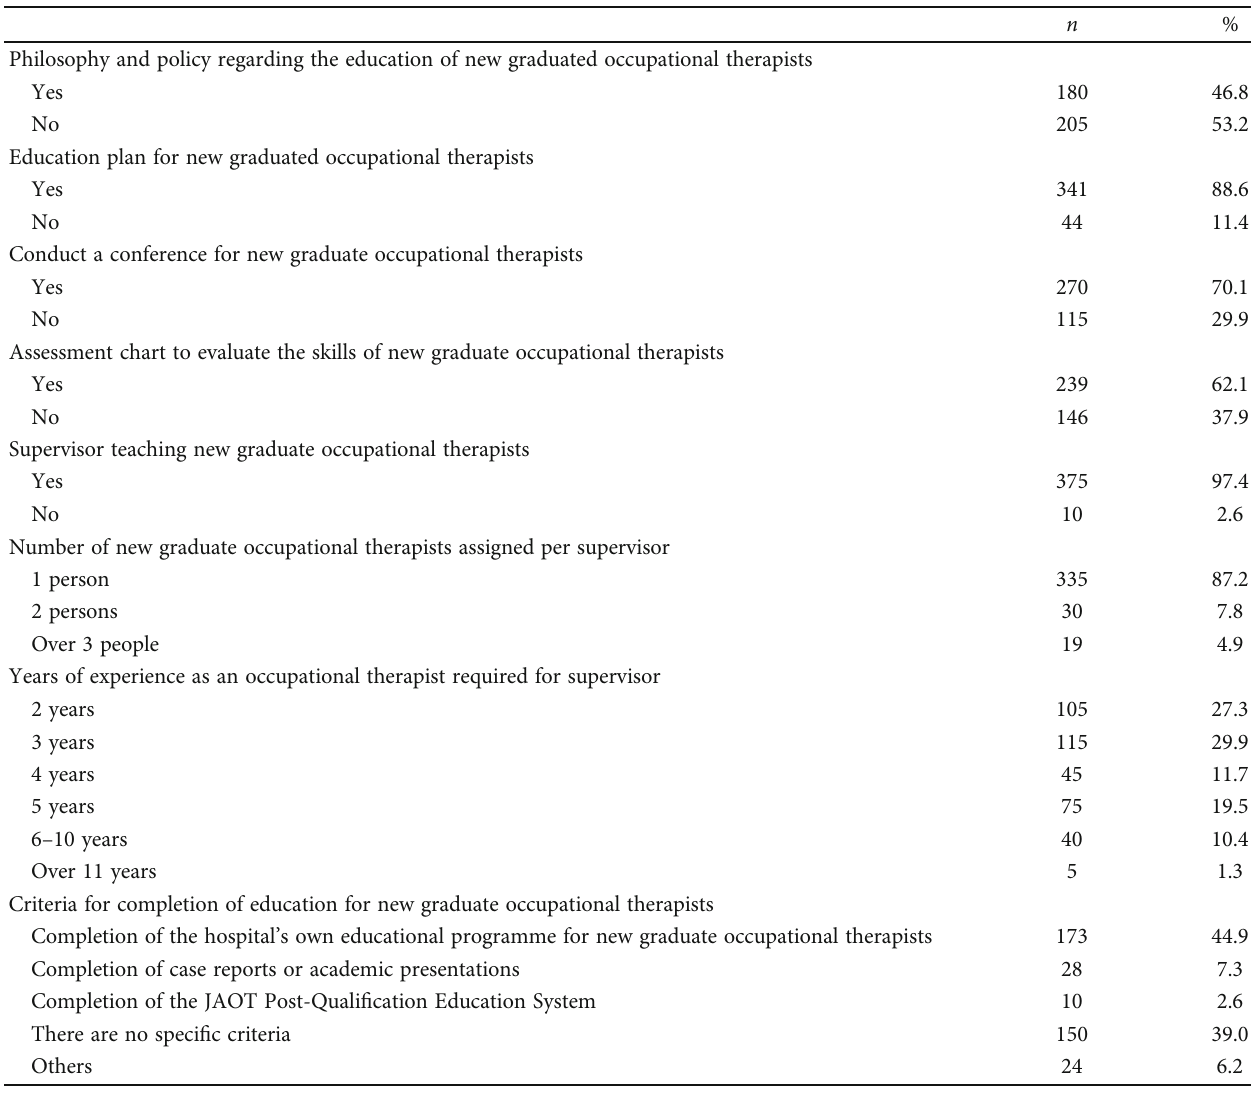
Table 2: Educational environment for new graduate occupational therapists in respondents ’ hospitals ( n = 385